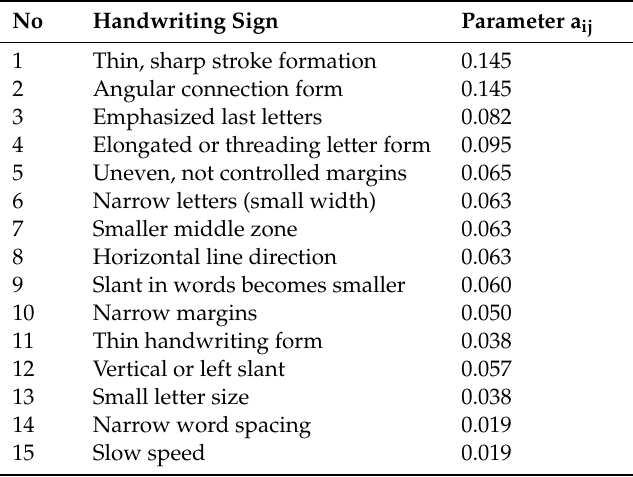
Table 2. Handwriting signs for trait “unresponsiveness”.